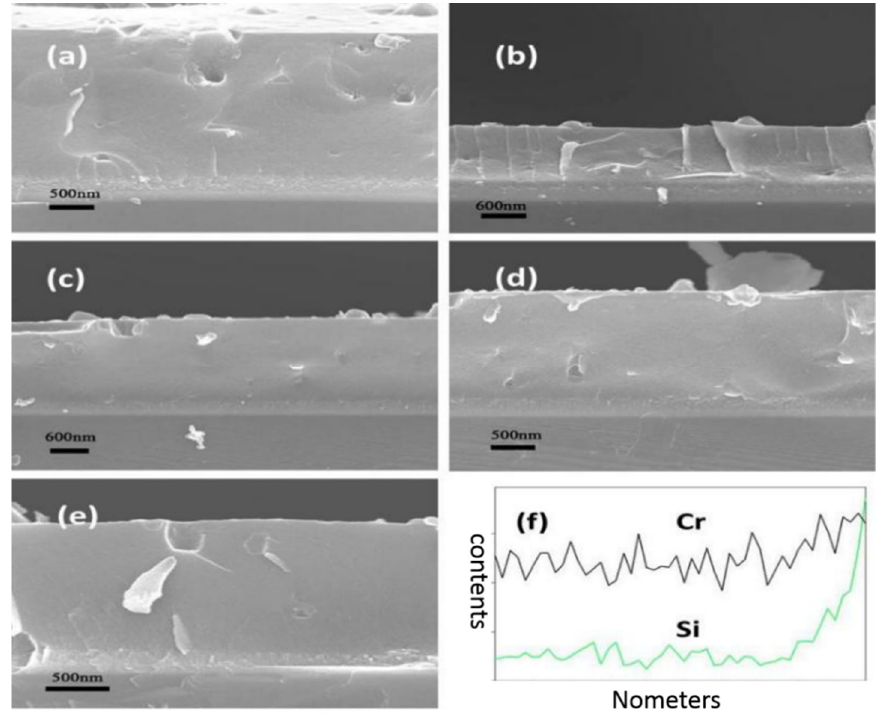
Figure 4. Cross-sectional image and line sweep spectrum of CrSiN coatings deposited under different currents. ( a ) 50 A, ( b ) 60 A, ( c ) 70 A, ( d ) 80 A, and ( e ) 90 A. ( f ) Line sweep spectrum of coatings prepared at 70 A.